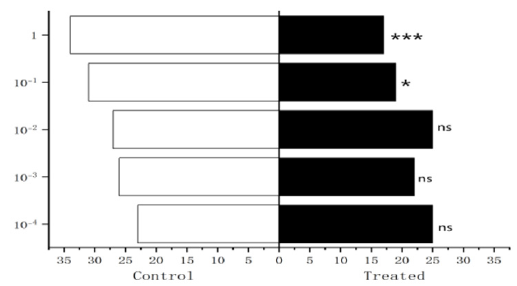
Figure 29. Behavioral responses to propyl butyrate in male W. magnifica .